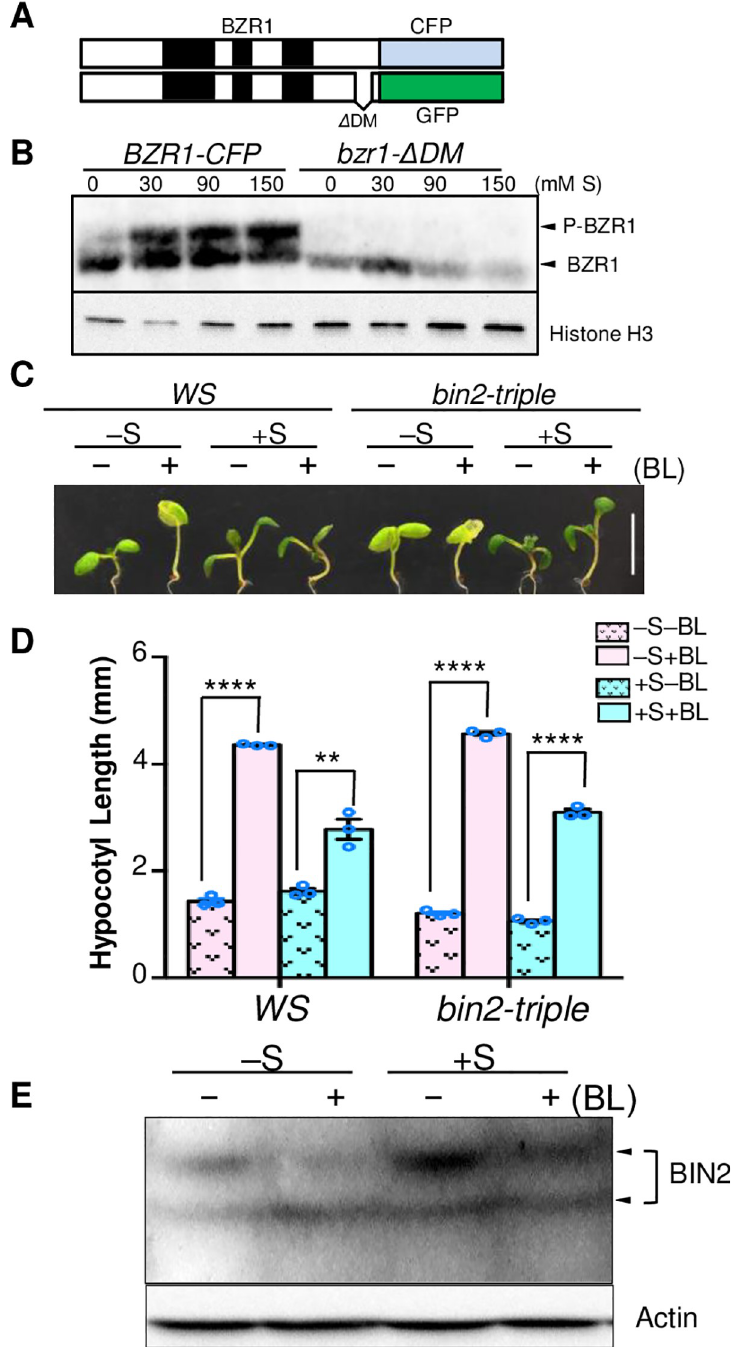
Fig 3. Sucrose inhibition of BR signaling depends on the regulation of BIN2. (A) Schematic presentation of BZR1-CFP and bzr1- Δ DM-GFP. (B) Immunoblot analysis of BZR1 protein in BZR1-CFP /Col-0 and bzr1- Δ DM-GFP /Col-0 seedlings grown on medium containing 100 nM eBL and different concentrations of sucrose (mM S). Histone H3 was probed as a loading control in the Immunoblot analysis. (C-D) Phenotypes and hypocotyl length of wild type (WS) and bin2bil1bil2 ( bin2-triple ) mutant seedlings grown on media containing no sucrose (-S) or 90 mM sucrose (+S) and 0 (-BL) or 10 nM BL (+BL). Bar = 5 mm. ���� P < 0.0001, ��� P < 0.001, �� P < 0.01 (Student’s t test). Error bars indicate the SEM (three replicates). (E) Anti-BIN2 immunoblot analysis of BIN2 proteins in seedlings grown on media containing 0 (-S) or 90 mM (+S) sucrose and 0 (-) or 10 nM (+) BL as indicated. The immunoblot was probed with an anti-Actin antibody as a loading